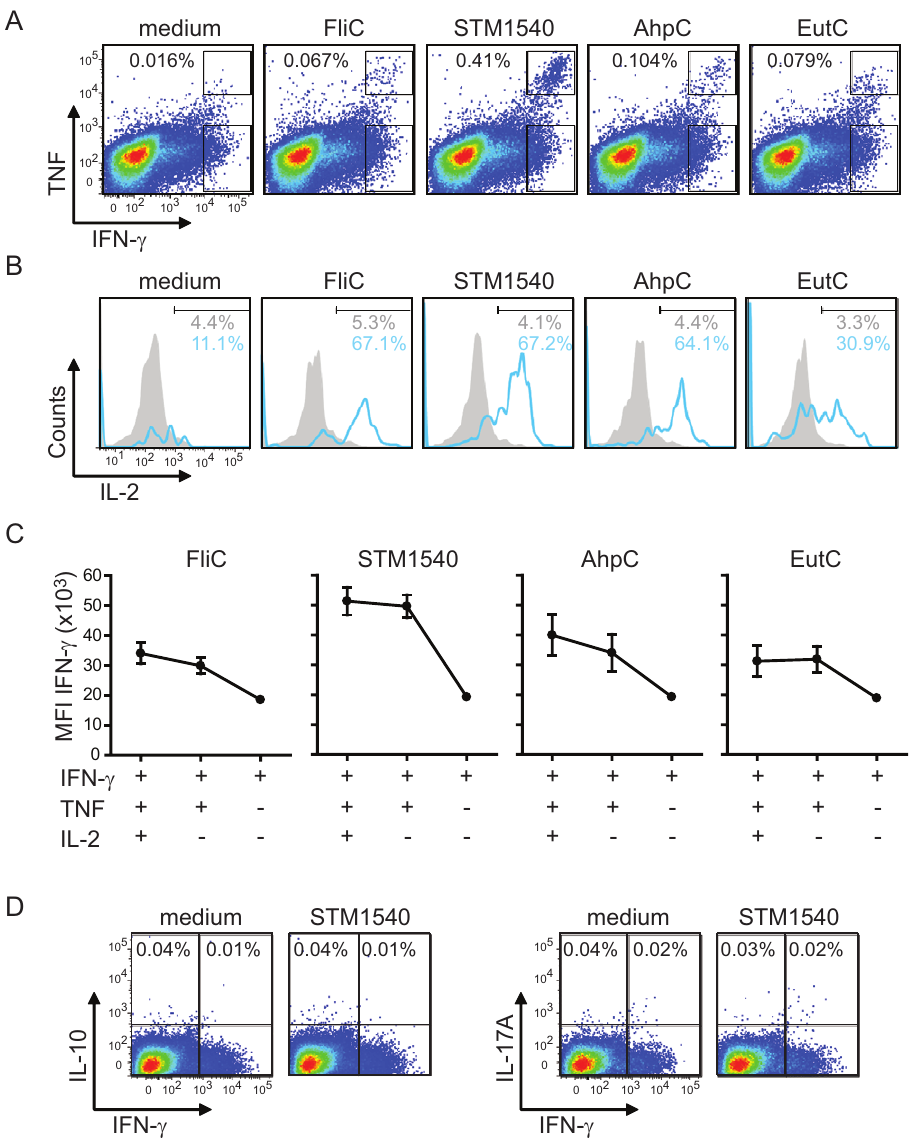
Figure 5. Development of polyfunctional CD4 + T cell responses during Salmonella infection. C57BL/6 mice were infected orally with 1 6 10 7 virulent Salmonella Typhimurium and at day 14 post-infection the cytokine profiles of Salmonella -specific CD4 + T cells were determined by polychromatic flow cytometry. (A) Shown are representative analyses of the IFN- c and TNF cytokine profiles gated on CD3 + CD4 + T cells, which were stimulated with dendritic cells that were either loaded with peptides (i.e. FliC 429–443 , STM1540 262–276 , AhpC 154–168 or EutC 243–257 ) or not loaded with peptide (medium). The percentage of IFN- c + TNF + within the CD3 + CD4 + T cell population is indicated. (B) Histogram plots show the percentage of IL-2 positive cells within the double IFN- c + TNF + (blue line) and single IFN- c + (filled grey histograms) population. (C) Shown is the IFN- c mean fluorescence intensity (MFI) 6 SEM of epitope-specific triple IFN- c + TNF + IL-2 + , double IFN- c + TNF + and single IFN- c + CD3 + CD4 + T cells. (D) Shown are representative analyses of the intracellular IL-10, IL-17A and IFN- c expression of CD3 + CD4 + T cells, which were stimulated with dendritic cells that were loaded with STM1540 262–276 peptide or not loaded with peptide (medium). The numbers indicate the percentage of cells that are positive for the indicated cytokines in each quadrant. Four independent experiments were performed with four mice per